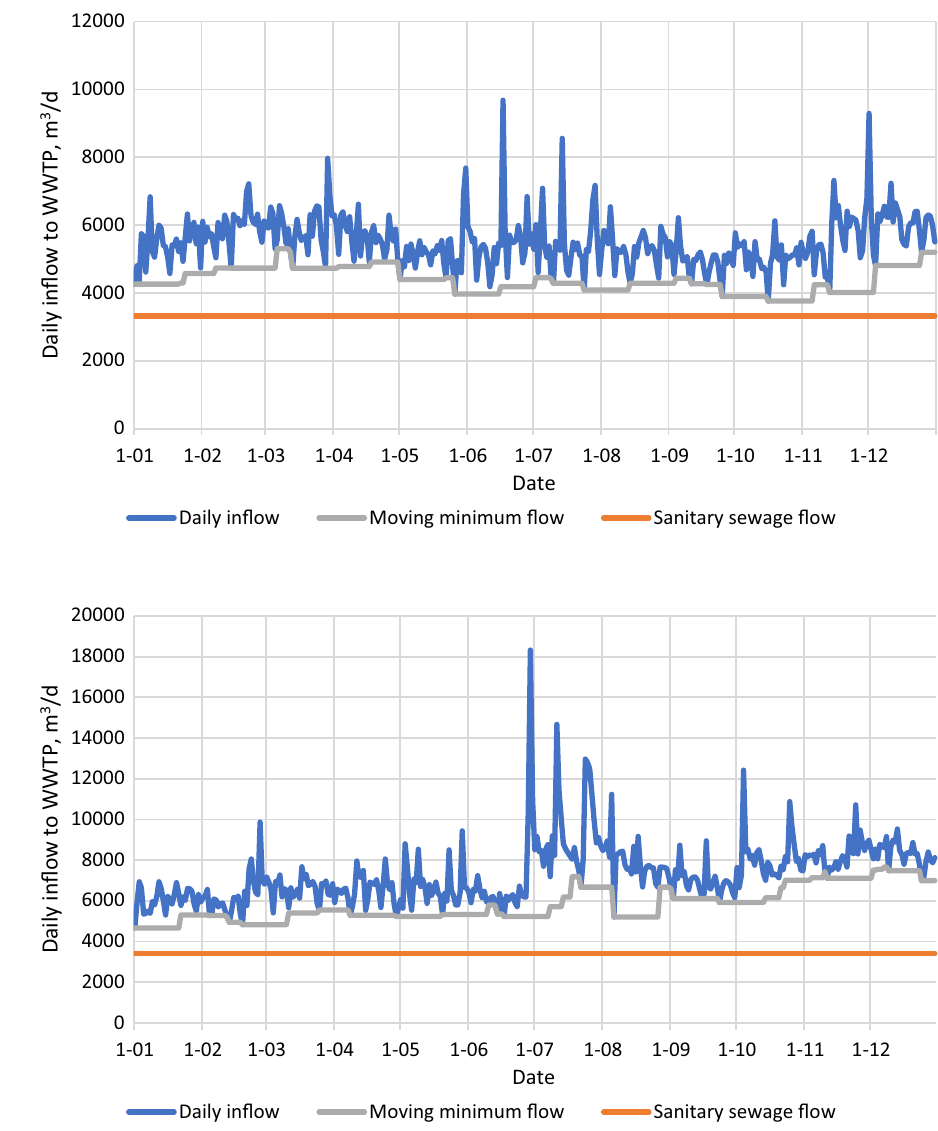
Fig. 10 Moving minimum flow plotted on a daily inflow diagram in the year 2016